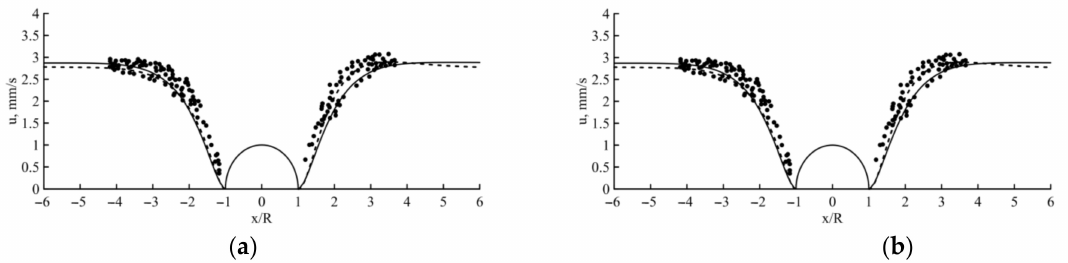
Figure 3. Cross-section axial velocities ( a ) and centerline velocity ( b ) solid line—4-mode Giesekus model with λ = 1.74, dashed line—2-mode Giesekus model with λ = 0.84, dots—experiment [5] ( V a = 1.975